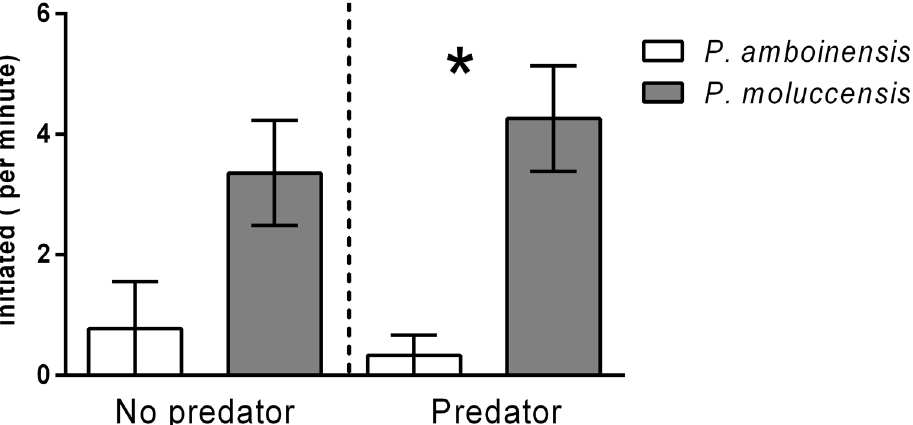
Fig 5. Mean ( ± 1 SE) agonistic interactions (i.e. chases) initiated by P . amboinensis and P . moluccensis in the interspecific competition treatment (PA1:PM1), separated by predator absence or presence. Asterisks indicate significant differences between species within each predator treatment